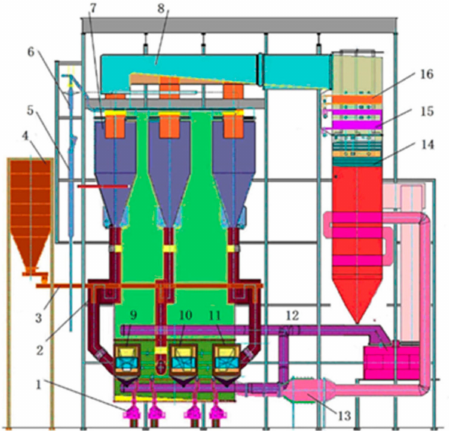
Figure 1. Schematic diagram of the 600 MW CFB boiler (1-slag cooler; 2-material returning device; 3-coal feeding route; 4-coal bunker; 5-storage tank; 6-steam separator; 7-cyclone separator; 8-flue duct; 9,10,11-fluidized bed heat exchangers (FBHEs); 12-secondary air duct; 13-ignition duct; 14- economizer; 15-low temperature reheater; 16-low temperature